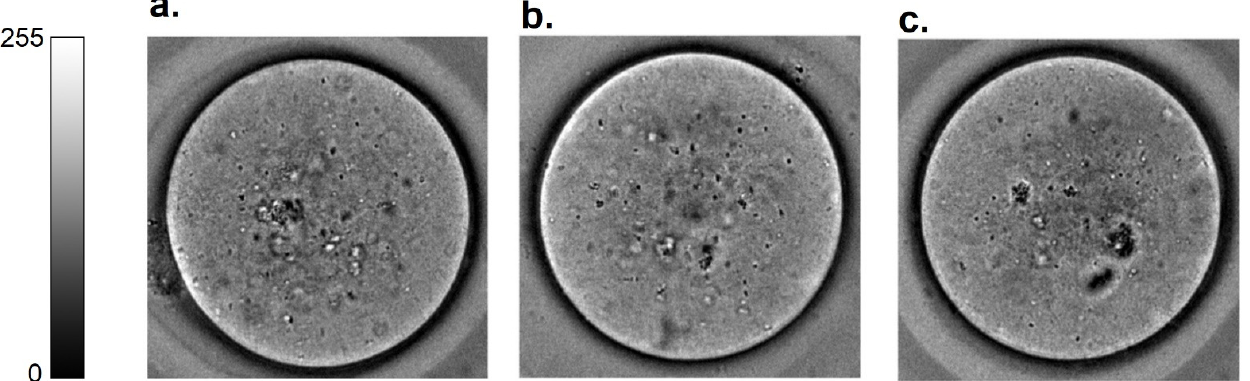
Figure 2. Representative brightfield images of oocytes from ( a ) young (4–5 weeks), ( b ) aged (12 months), and ( c ) aged animals treated with NMN. Oocytes from the different groups were morphologically indistinguishable by visual inspection.